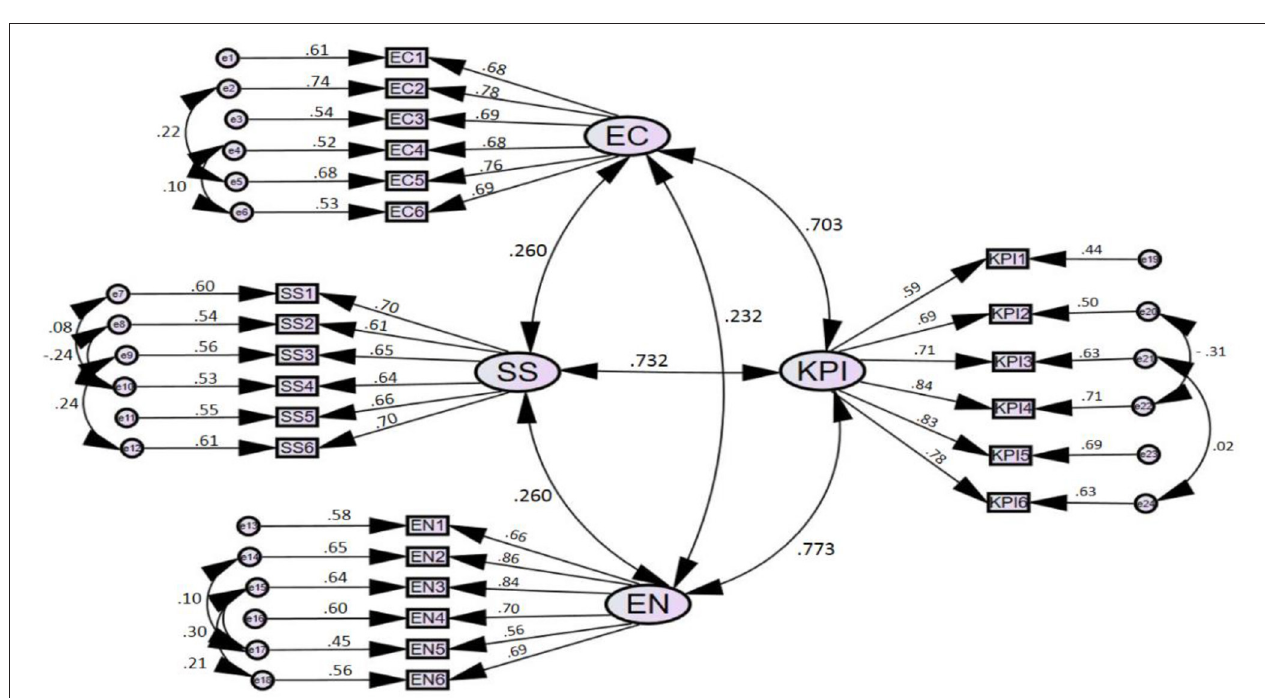
FIGURE 1 | Confirmatory analysis (CFA) for measuring sustainable environment.